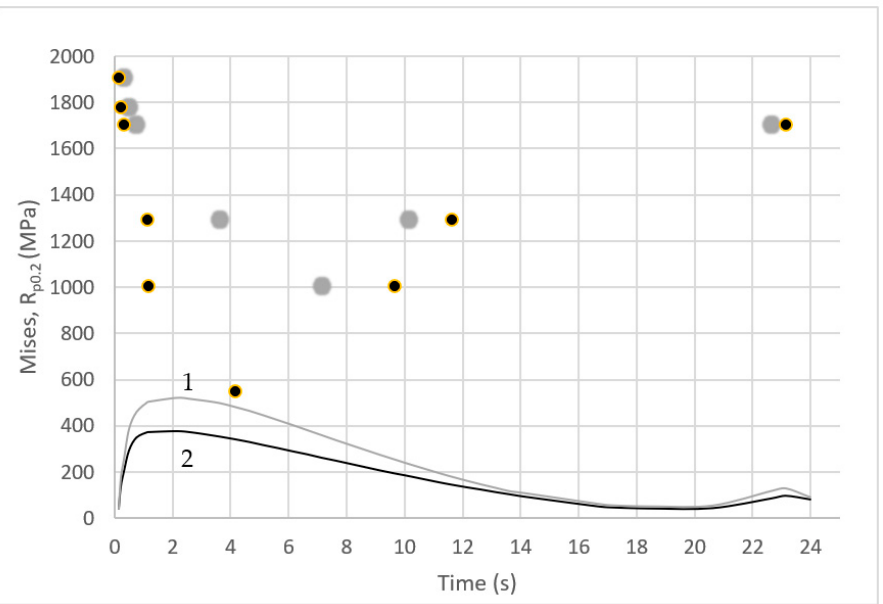
Figure 9. Changes in the Mises stress values occurring on the core surface during one cycle of the pressure machine: 1—near the notch (Point A of Figure 8); 2—on the external surface of the core (Point B of Figure 8) related to the instantaneous yield strength R p0.2 (grey and black points corresponding to colours of curves 1 and 2) determined on the basis of the numerically determined core temperature and the results of tensile test within the temperature range of 20–550 °C.